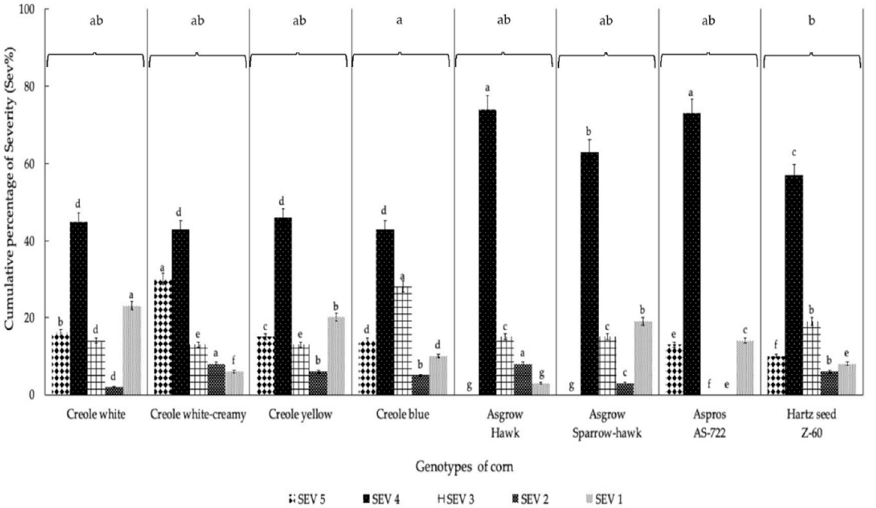
Figure 2. Accumulated degrees of severity (expressed as percentages) of infection of the U. maydis strain MA-Um1 for each genotype of corn in Nopalucan, Puebla, Mexico. Means followed by the same letter are not significantly different ( p ≤ 0.05) according to Tukey’s test. For the severity index (ISE), the values obtained for the Creole creamy-white treatment were highly significant ( p = 0.01) compared to other treatments, obtaining a value of 64.14% (Figure 3). The Asgrow Sparrow-hawk genotype represented the lowest ISE among the genotypes with